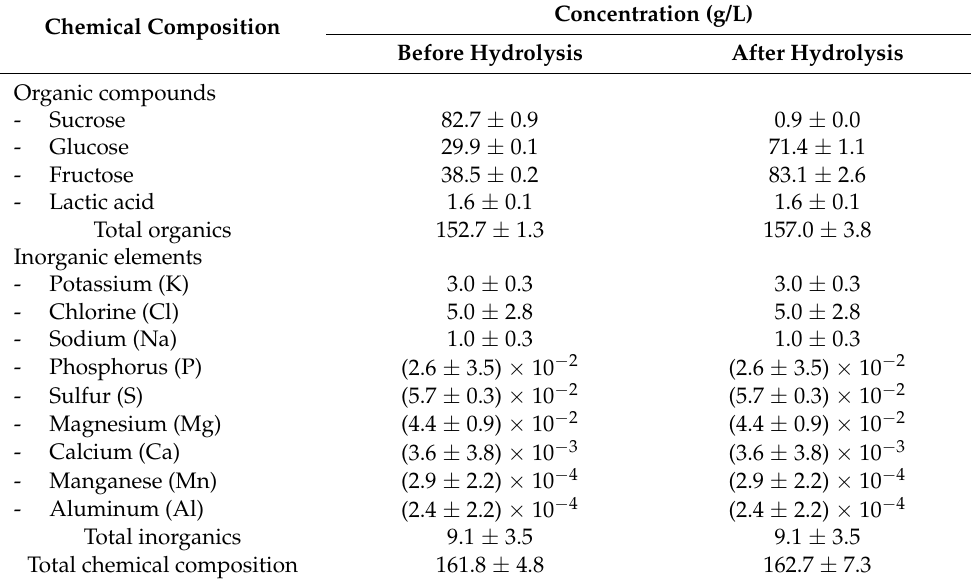
Table 2. Chemical composition of nipa sap before and after enzymatic